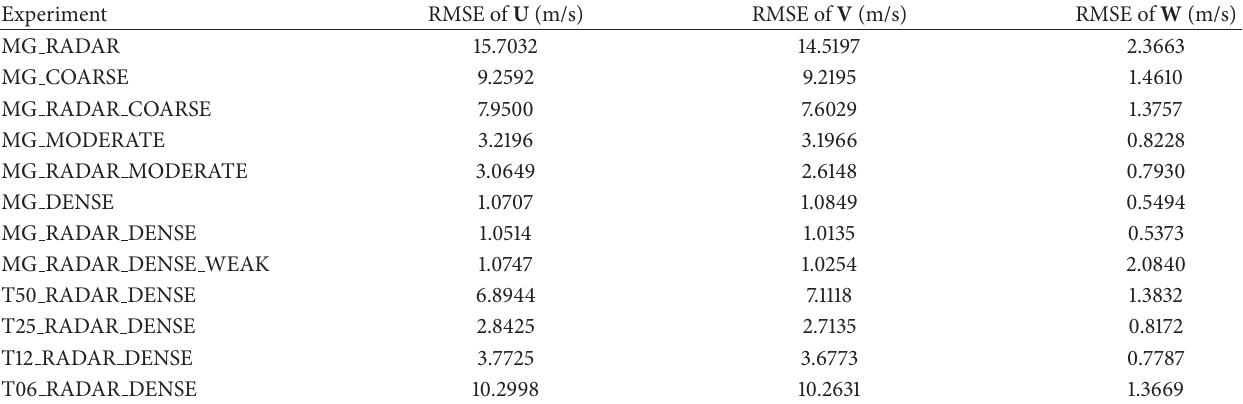
Table 1: Root mean square errors (RMSE) of U , V , and W component in different experiments. MG RADAR represents the STMAS results by only assimilating radial wind data. MG COARSE represents the STMAS results by assimilating only coarse conventional data. MG RADAR COARSE represents the STMAS results by assimilating both radial wind data and coarse conventional data. MG MODERATE and MG RADAR MODERATE are similar to MG COARSE and MG RADAR COARSE but with the conventional data substituted by moderate conventional data. MG DENSE and MG RADAR DENSE are similar to MG COARSE and MG RADAR COARSE but with the conventional data substituted by dense conventional data. MG RADAR DENSE WEAK is similar to MG RADAR DENSE but with weak constraint. T50 RADAR DENSE represents the results of traditional 3D-Var with correlation scales being 𝐿 𝑥 = 50 km, 𝐿 𝑦 = 50 km, and = 5 km by assimilating both radial wind data and dense conventional data; T25 RADAR DENSE is similar to T50 RADAR DENSE but 𝐿 𝑧 for 𝐿 𝑥 = 25 km, 𝐿 𝑦 = 25 km, and 𝐿 𝑧 = 2.5 km; T12 RADAR DENSE is similar to T50 RADAR DENSE but for 𝐿 𝑥 = 12.5 km, 𝐿 𝑦 = 12.5 km, and 𝐿 𝑧 = 1.25 km; T06 RADAR DENSE is similar to T50 RADAR DENSE but for 𝐿 𝑥 = 6.25 km, 𝐿 𝑦 = 6.25 km, and 𝐿 𝑧 = 0.625 km. Experiment RMSE of U (m/s) RMSE of V (m/s) RMSE of W